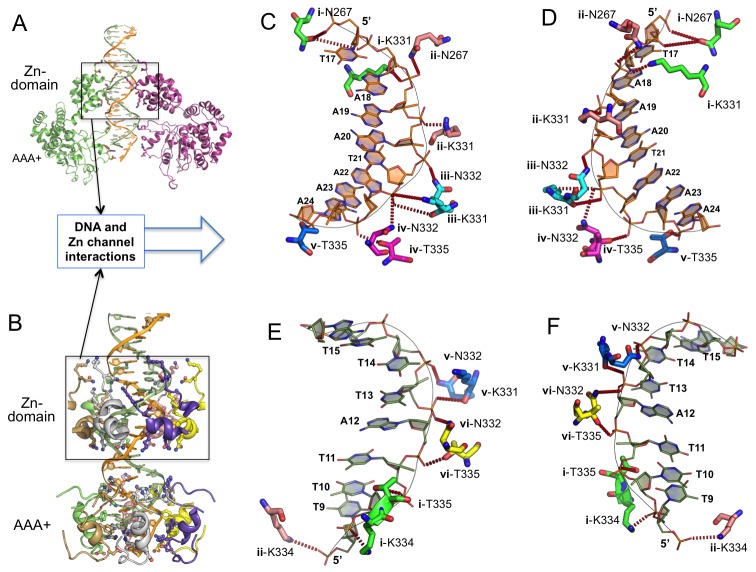
Detailed interactions of origin DNA with the Zn-domain of LT.(A, B) Two different views of dsDNA inside the LT hexameric channel, one with two complete subunits out of six (A) and the other with the DNA-binding residues on the Zn and AAA+ domains of all six subunits (B). (C, D) Two views tshowing the detailed interactions of the 5’→3’ DNA strand with LT residues inside the Z-domain channel from the N→C direction. The six subunits are labeled as i, ii, iii, iv, v, vi. The residues contacting the DNA are shown as sticks. (E, F) Two views showing the detailed interactions of the 3’→5’ DNA strand with LT residues inside the Z-domain channel from the N→C direction.